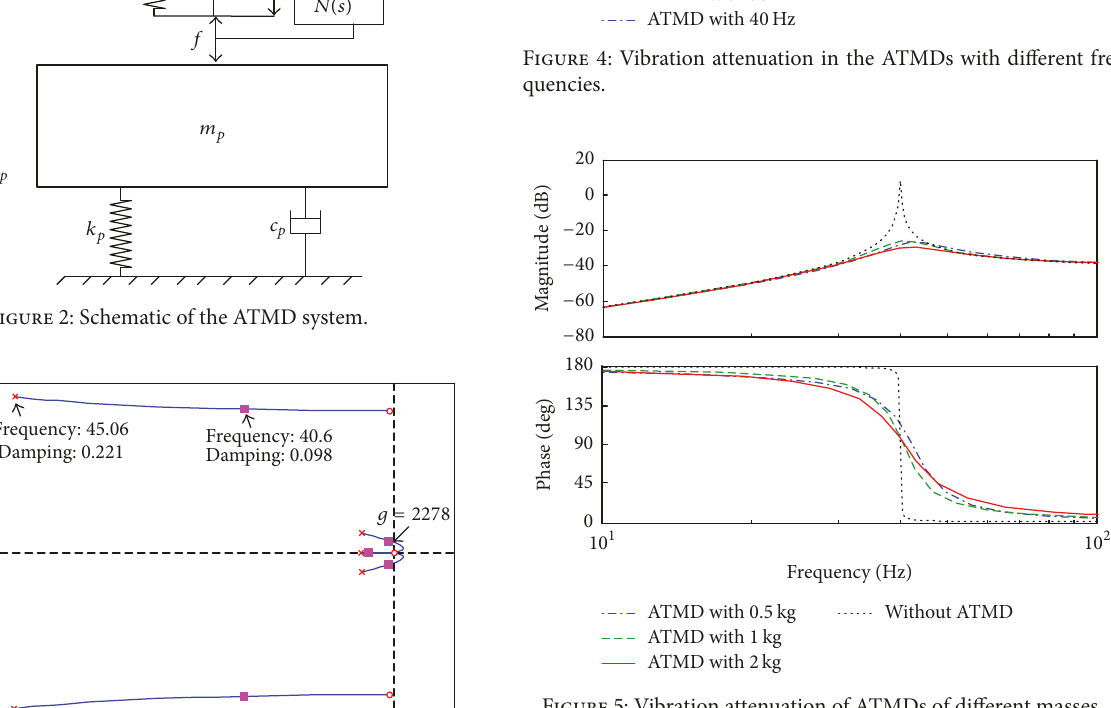
Figure 5: Vibration attenuation of ATMDs of different